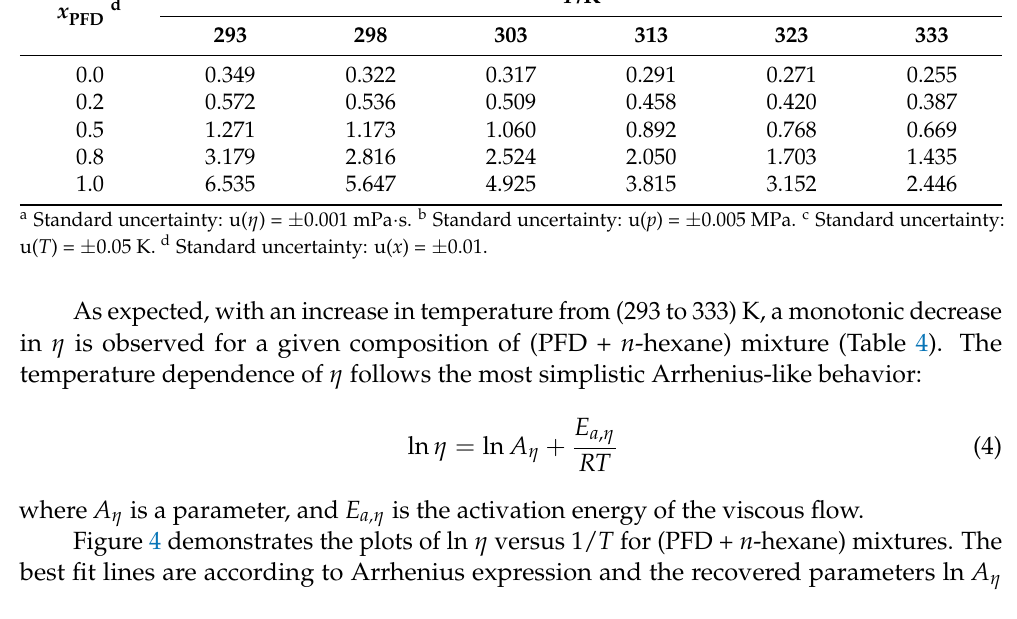
Table 4. Dynamic viscosity a ( η /mPa · s) of the investigated mixtures of PFD and n -hexane at different mole fraction ratios at pressure p b = (0.1 MPa) and temperature T c = (293 K to 333 K). x PFD